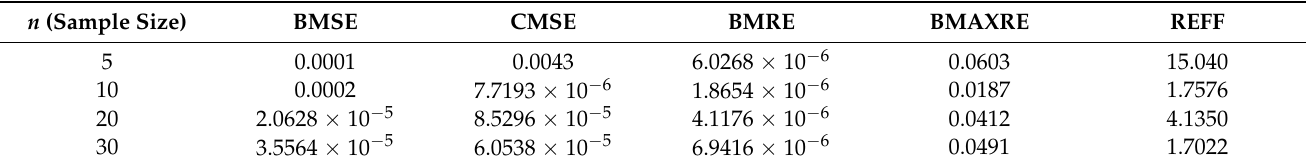
Table 7. Estimation efficiency: numerical results for case A3.